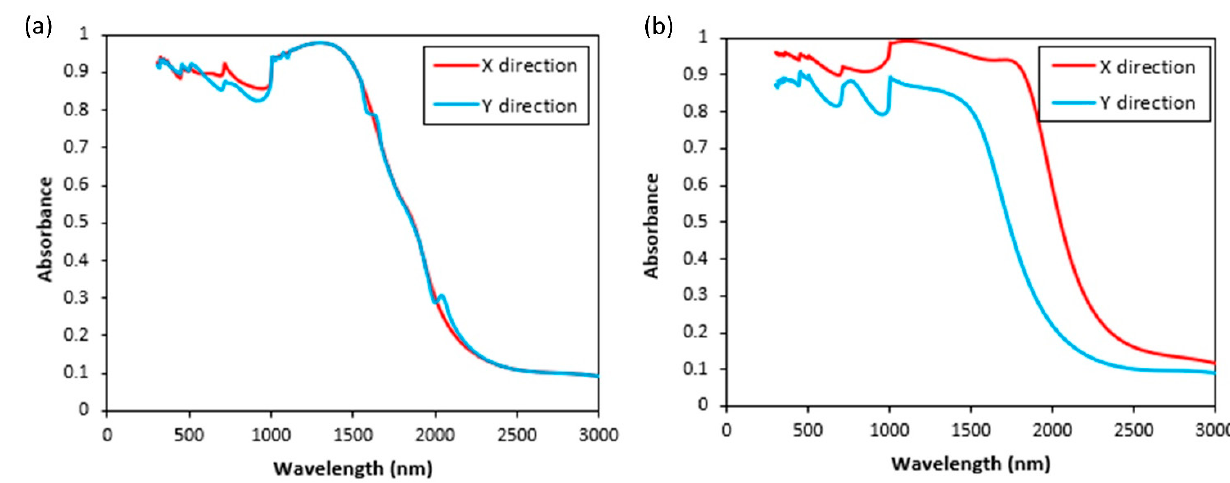
Figure 9. Polarization direction effect on the absorption spectrum for ( a ) isotropic surface (l = 200 nm, h = 180 nm). ( b ) Anisotropic surface (l x = 100 nm, l y = 400 nm, and h = 180 nm).